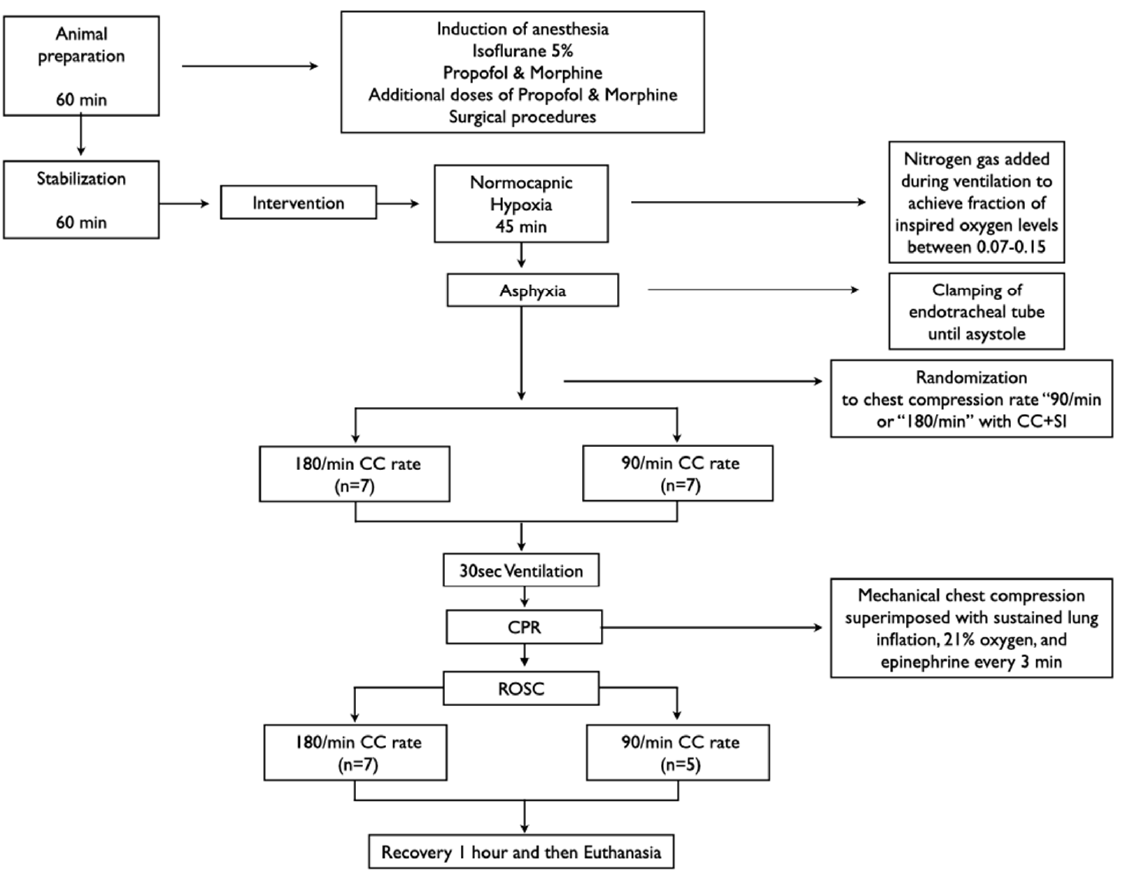
Figure 1. Study flow